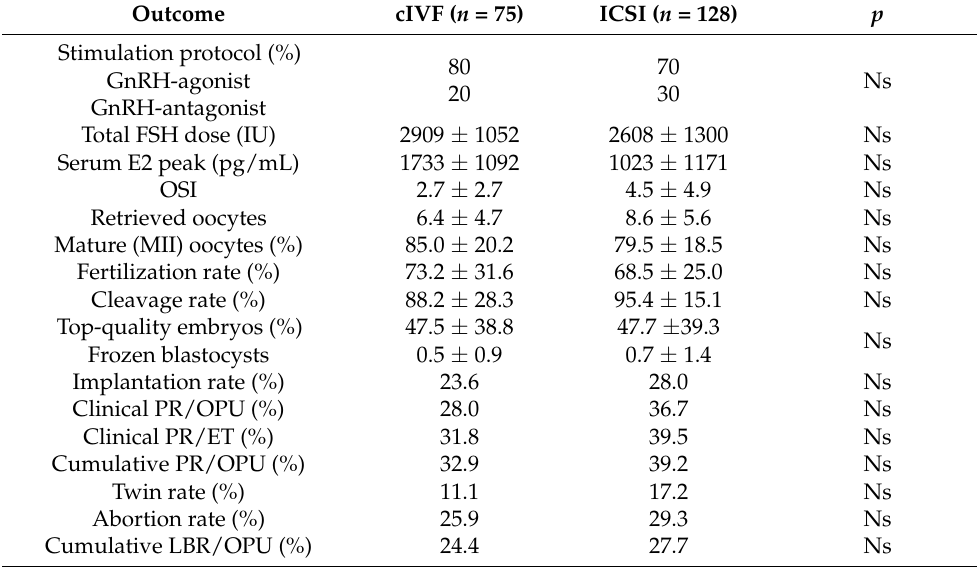
Table 2. Outcome of 203 assisted reproduction cycles of patients with ovarian endometriosis under- going cIVF or ICSI. All differences were not